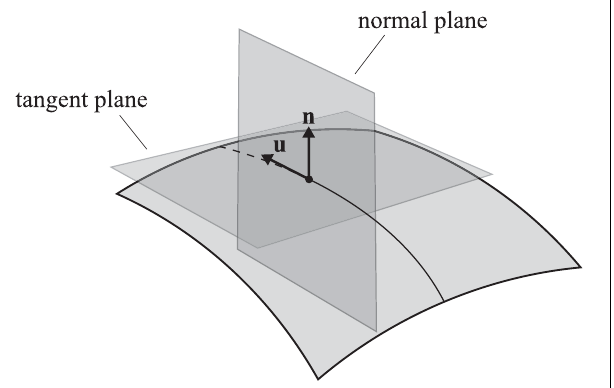
FIGURE 3 | A trajectory on a two-dimensional curved surface. Indicated are the tangent vector u and the surface normal n . The normal plane contains both vectors and the tangent plane contains only the tangent vector and is perpendicular to the normal vector.